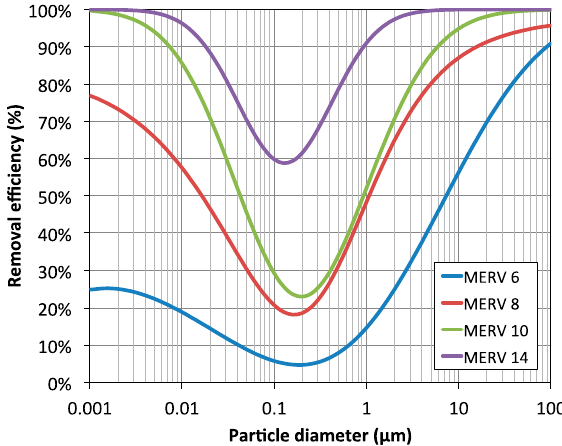
Figure 4. Size-resolved removal efficiency curves for four MERV-rated filters in Hecker and Hofacre (2008) [35].